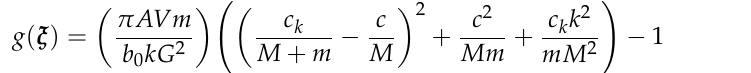
Figure 4. Schematic view of a passive vehicle suspension model.